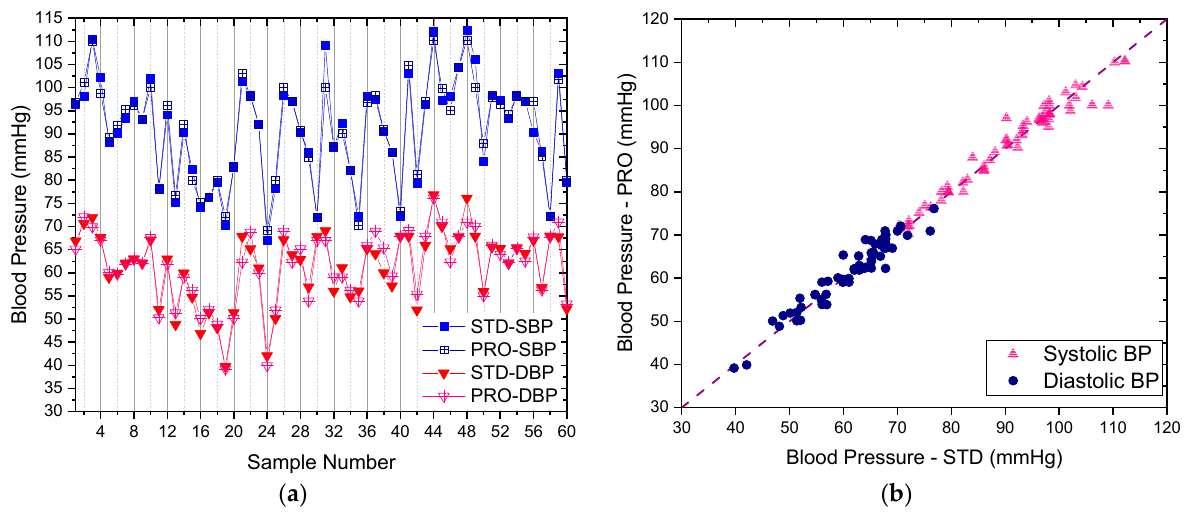
Figure 10. The comparison of systolic and diastolic blood pressure results between the proposed smart devices (PRO) and